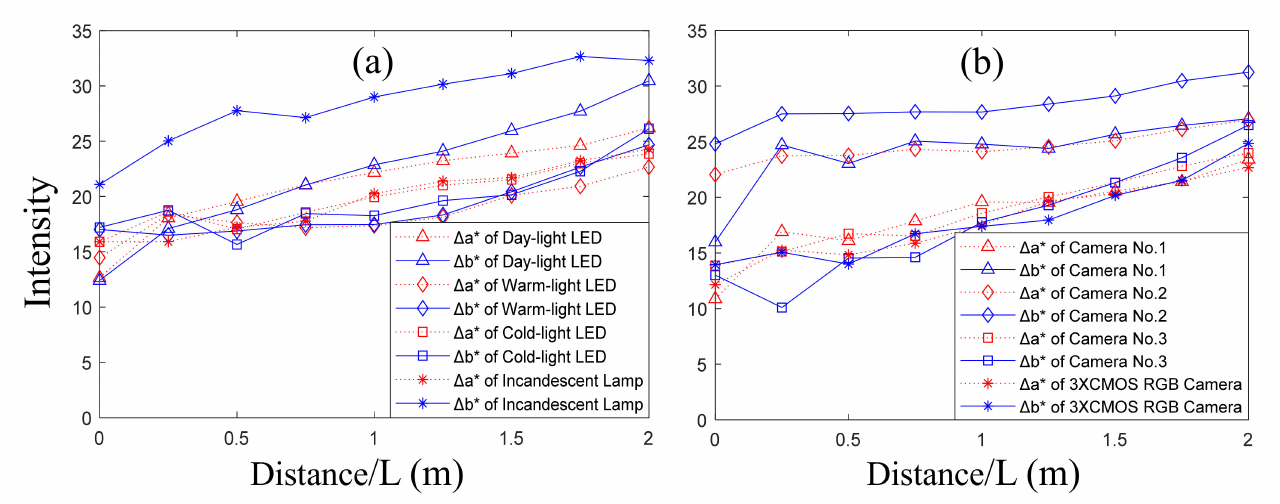
Figure 10. The values of ∆ a ∗ and ∆ b ∗ with four kinds of lamps and four kinds of cameras: ( a ) ∆ a ∗ and ∆ b ∗ with different lamps; ( b ) ∆ a ∗ and ∆ b ∗ with different cameras.